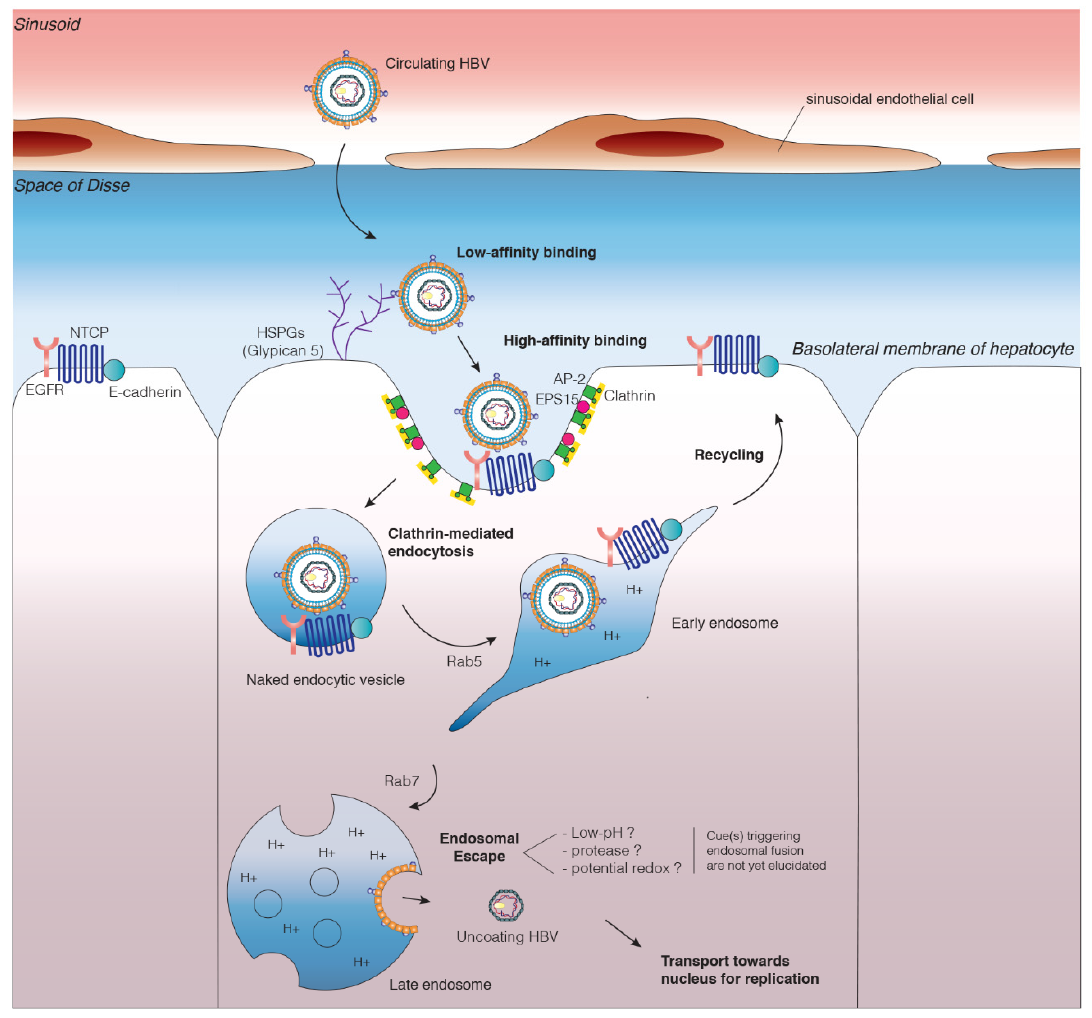
Figure 2. Early events in the life cycle of hepatitis B virus. HBV interacts with heparan sulfate proteoglycans (HSPGs), including glypican 5 in particular, on the hepatocyte cell membrane. HBV binds its receptor sodium taurocholate co-transporting polypeptide (NTCP) and its coreceptor epidermal growth factor receptor (EGFR). This internalization complex is associated with E-cadherin linked to N-glycosylated NTCP. This association permits the relocalization of NTCP to the plasma membrane. The HBV–NTCP–EGFR complex is taken up into the cell by clathrin-mediated endocytosis. The EGFR sorting machinery coordinates HBV transport in the endosomal network. Endosomal escape remains incompletely understood, but it has been suggested that the localization of HBV to late endosomes is crucial for productive infection and that fusion may occur in this compartment. The cues triggering endosomal fusion have yet to be clearly elucidated. Following endosomal escape, the free nucleocapsid is thought to use the microtubule network for transit to the nucleus, where it dissociates at the nuclear pore complex. Once within the nucleus, the relaxed circular DNA is converted into cccDNA, which acts as a template for transcription.